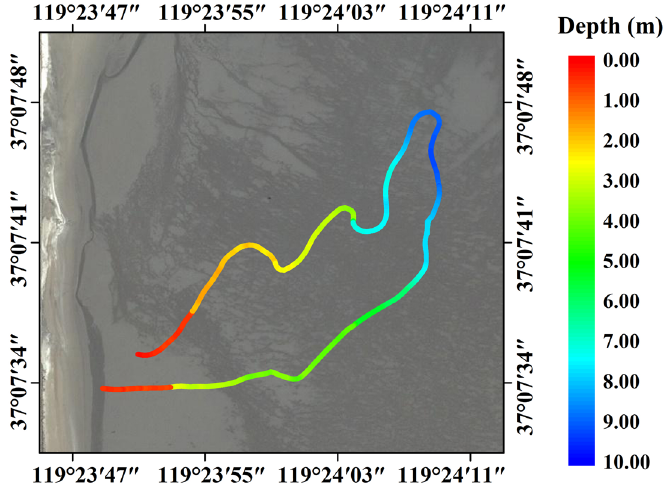
Figure 12. Distribution trajectory and bathymetric results at the Weifang test field.